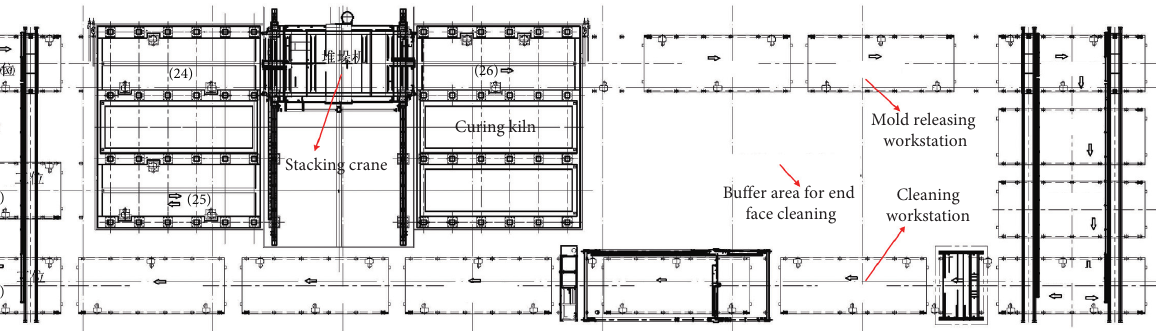
Figure 4: Production line diagram regarding semiprecast slabs.